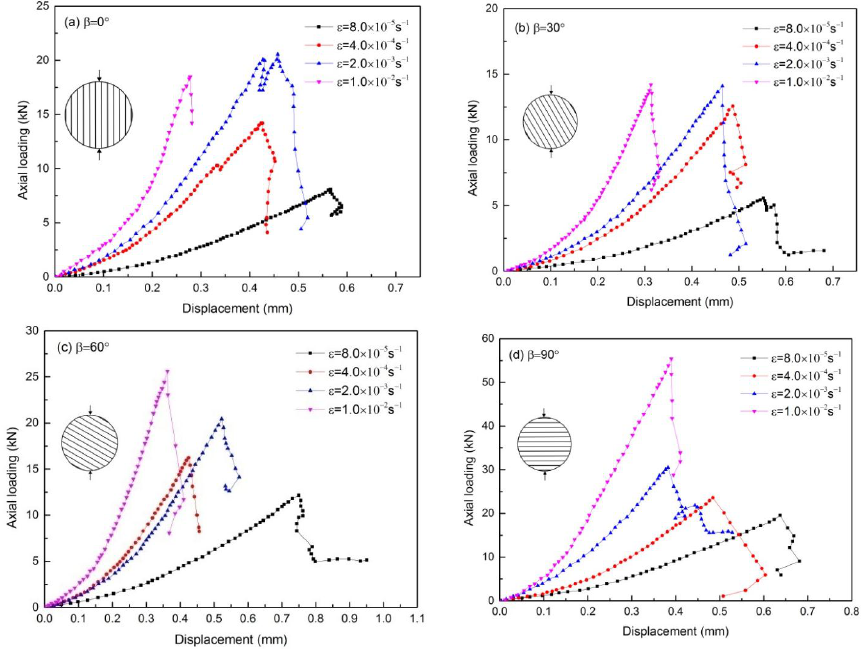
Figure 3. Plots of relationship between axial force and loading displacement for samples with orientation 0°, 30°, 60°, and 90°, respectively.